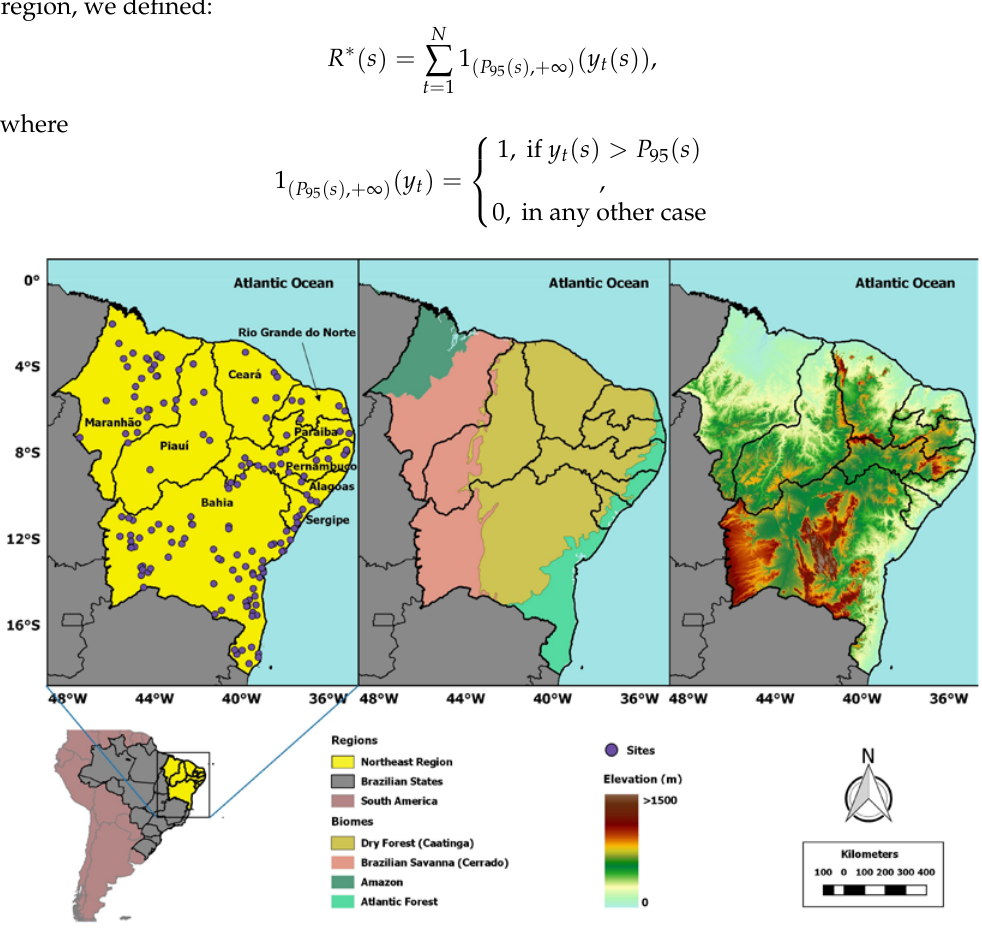
Figure 1. Location of the rain gauges ( left panel), biome map ( center panel) and NEB topography ( right panel) according to the division by federal states.